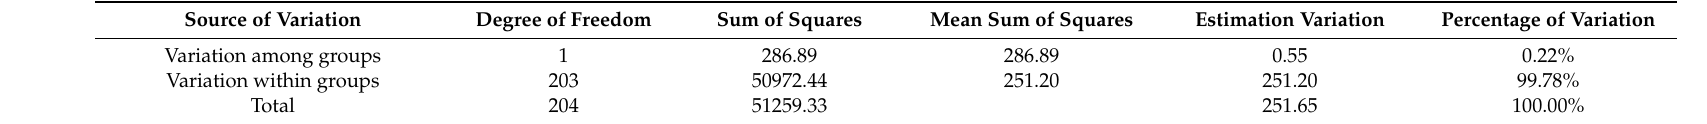
Table 3. Result of the AMOVA between the core collection and the rest of the population. Source of Variation Degree of Freedom Sum of Squares Mean Sum of Squares Estimation